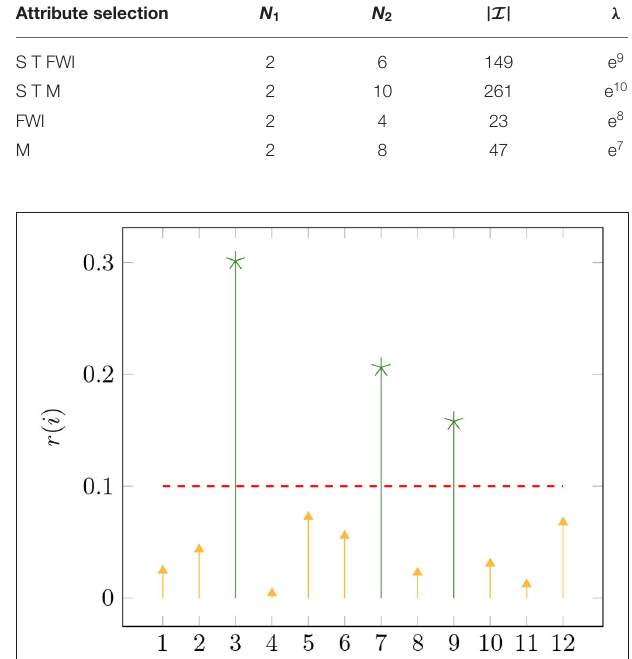
1,2, ... ,12, of the approximation with all = N 2 2 and λ = = =